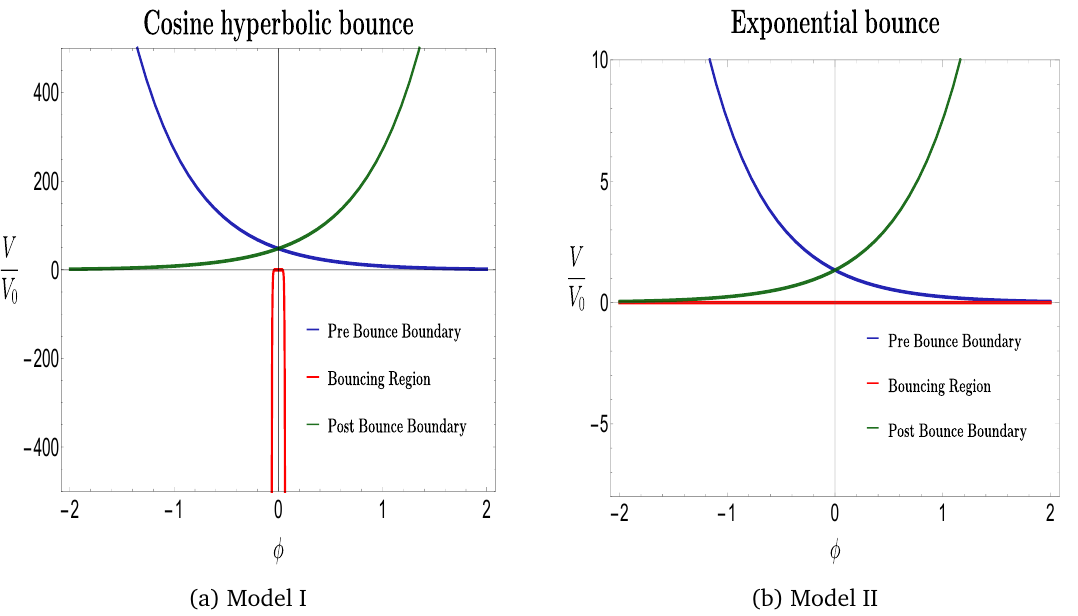
Figure 2: Behaviour of the potentials of the considered models with respect to the field variable φ